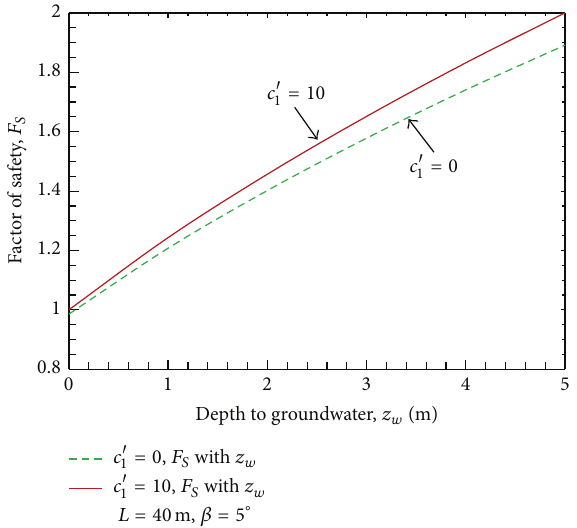
Figure 4: Influence of the depth of groundwater 𝑧 𝑤 on 𝐹 𝑆